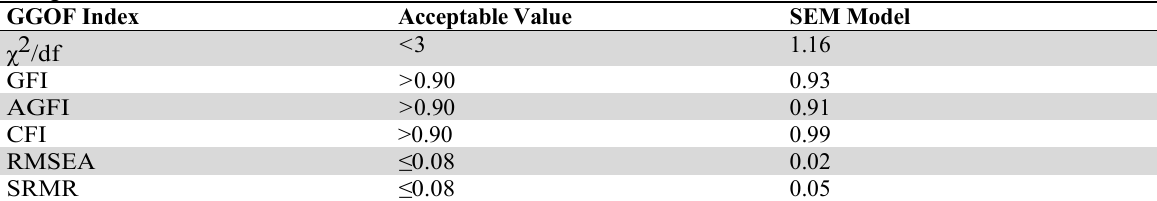
SEM goodness-of-fit statistic.